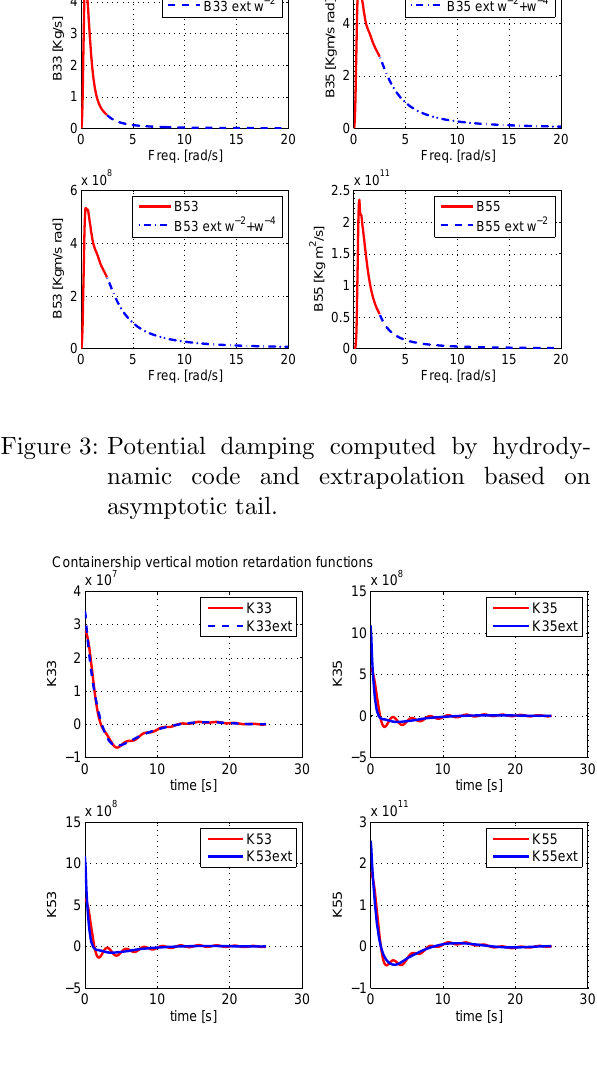
Figure 4: Retardation functions computed from the potential